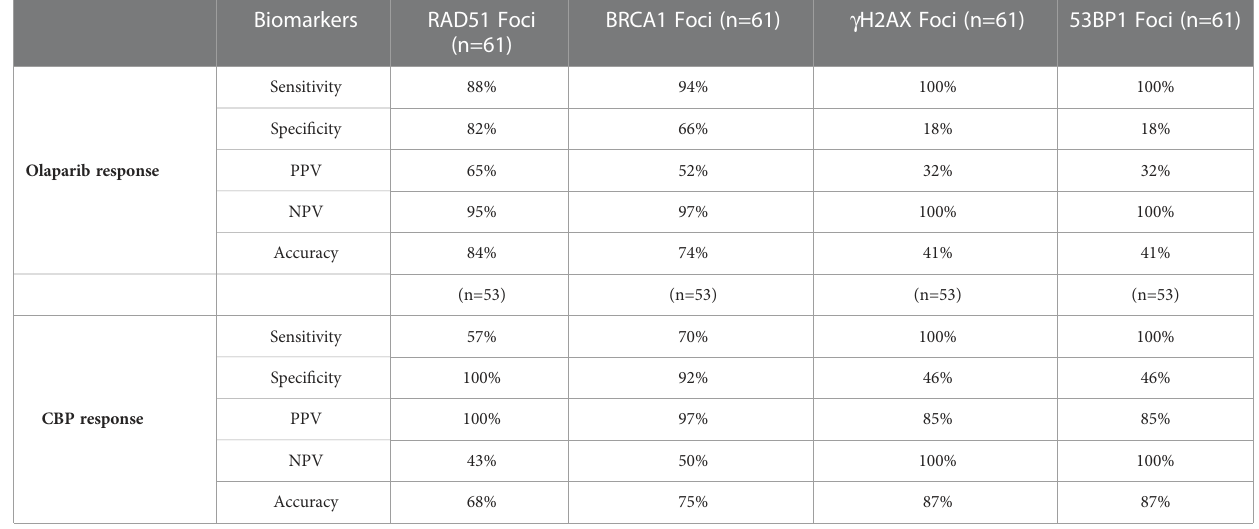
TABLE 2 Test performance values for the indicated HRD biomarkers to predict olaparib and CBP